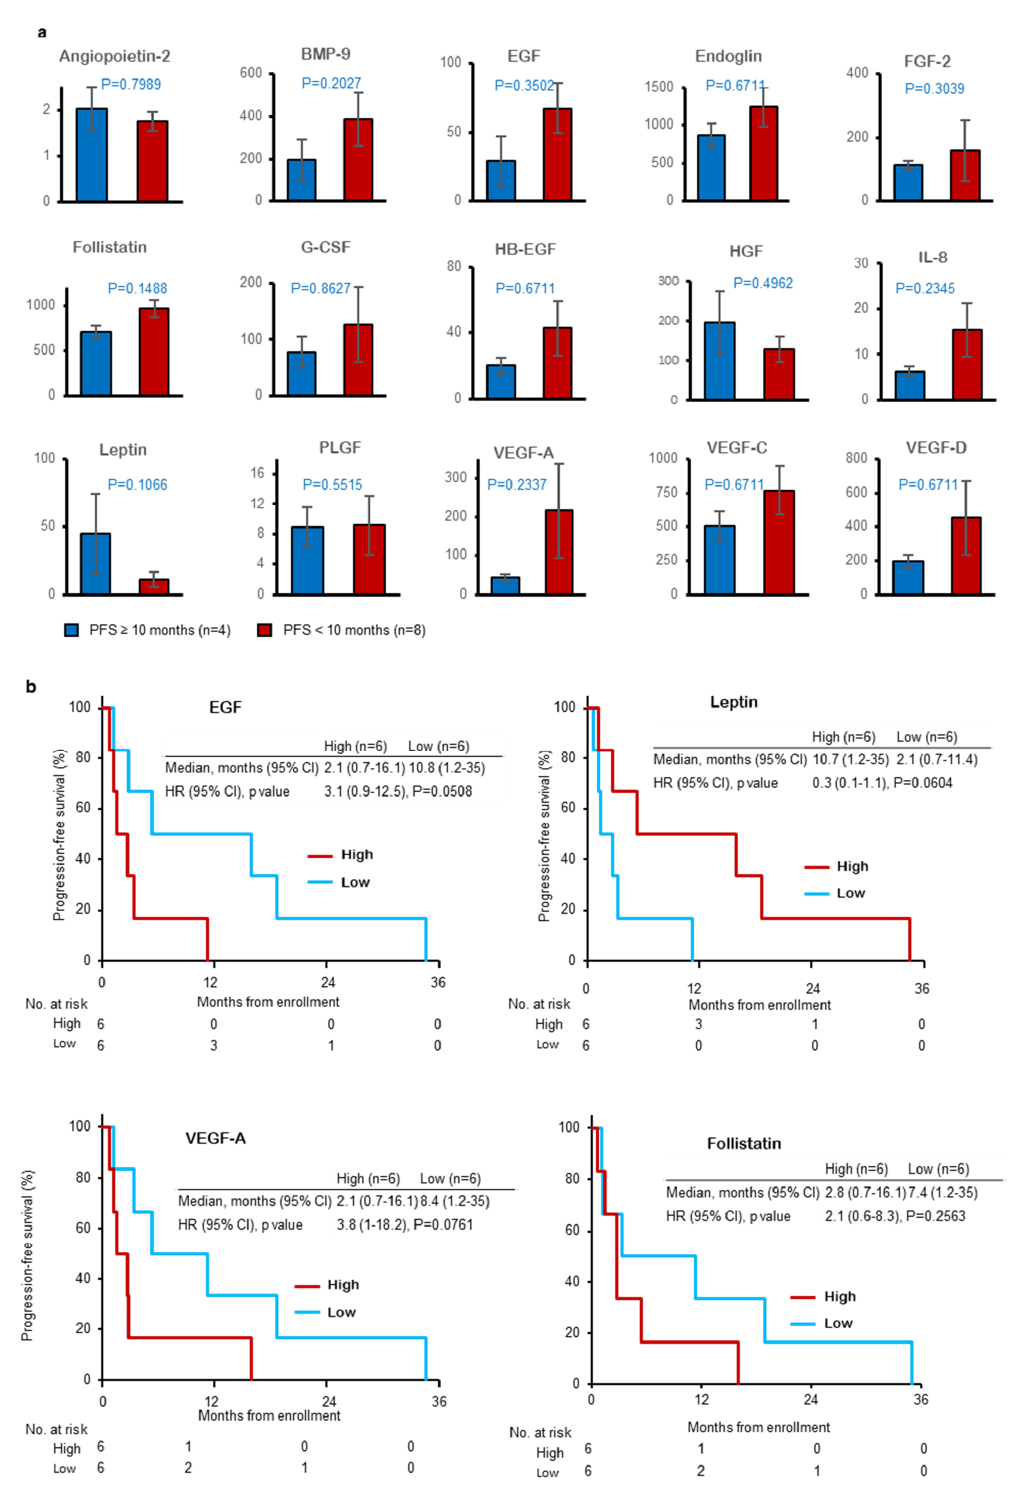
Figure 4. Correlation of plasma protein levels with progression-free survival. ( a ) Levels of plasma protein between patients with longer ( ≥ 10 months, 4 patients) and shorter progression-free survival (<10 months, 8 patients). ( b ) Progression-free survival curves of patients with high or low levels of EGF, leptin, VEGF-A and follistatin. BMP-9; bone morphogenetic protein-9, EGF; epidermal growth factor, FGF-2; fibroblast growth factor-2, G-CSF; granulocyte colony stimulating factor, HB-EGF; heparin-binding EGF-like growth factor, PLGF; placental growth factor, VEGF; vascular endothelial growth